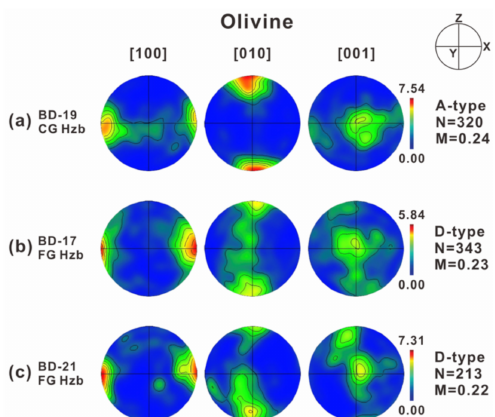
Figure 5. Pole figures showing the lattice preferred orientations (LPOs) of olivine from coarse-granular (CG) and fine-granular (FG) harzburgite (Hzb) from the Baekdusan peridotites. ( a ) The LPO of olivine in coarse-granular peridotite (BD-19). ( b , c ) The LPOs of olivine in fine-granular peridotites (BD-17, BD-21). The east–west direction corresponds to the stretching lineation (X), and the north–south direction (Z) is normal to the foliation. Color-coding represents the density of data points. Equal-area lower-hemisphere projection was used with a half scattering width of 20 ◦ . N indicates the number of grains measured. Olivine fabric (LPO) strength is denoted by M (M-index) [42].